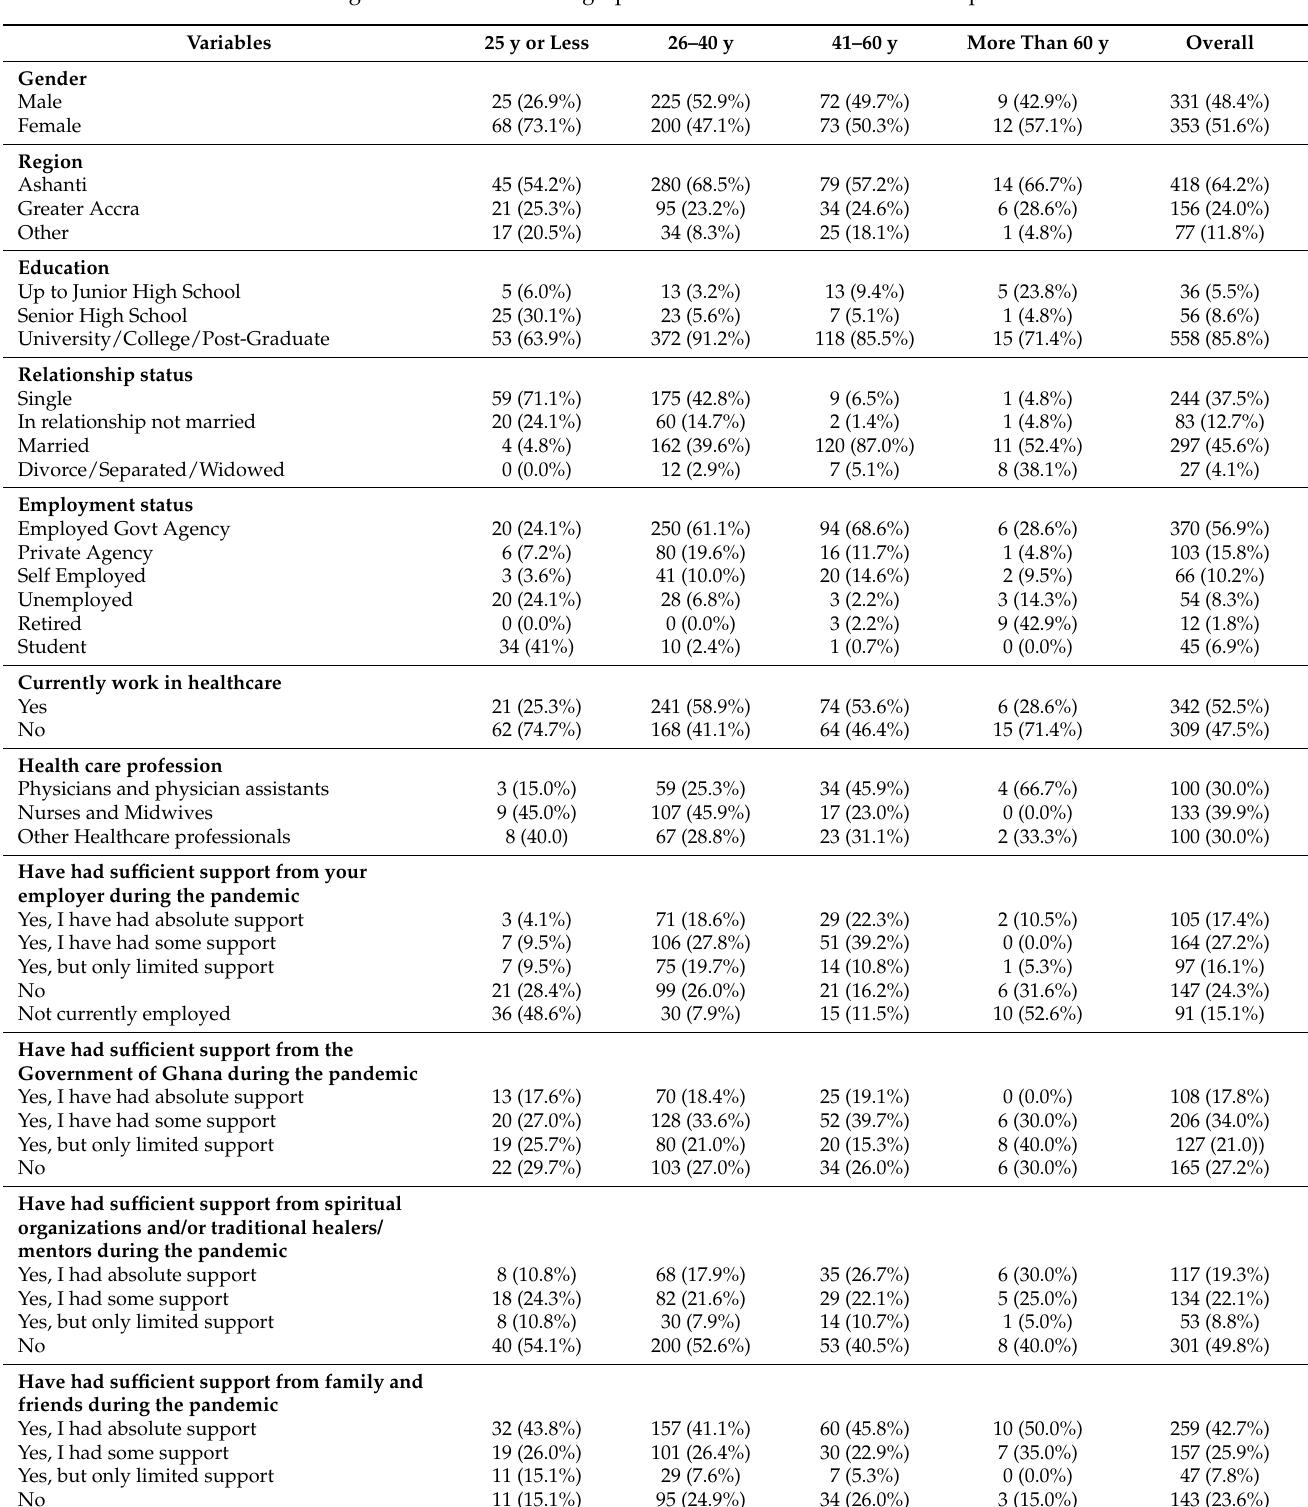
Table 1. Age distribution of demographic and social characteristics of